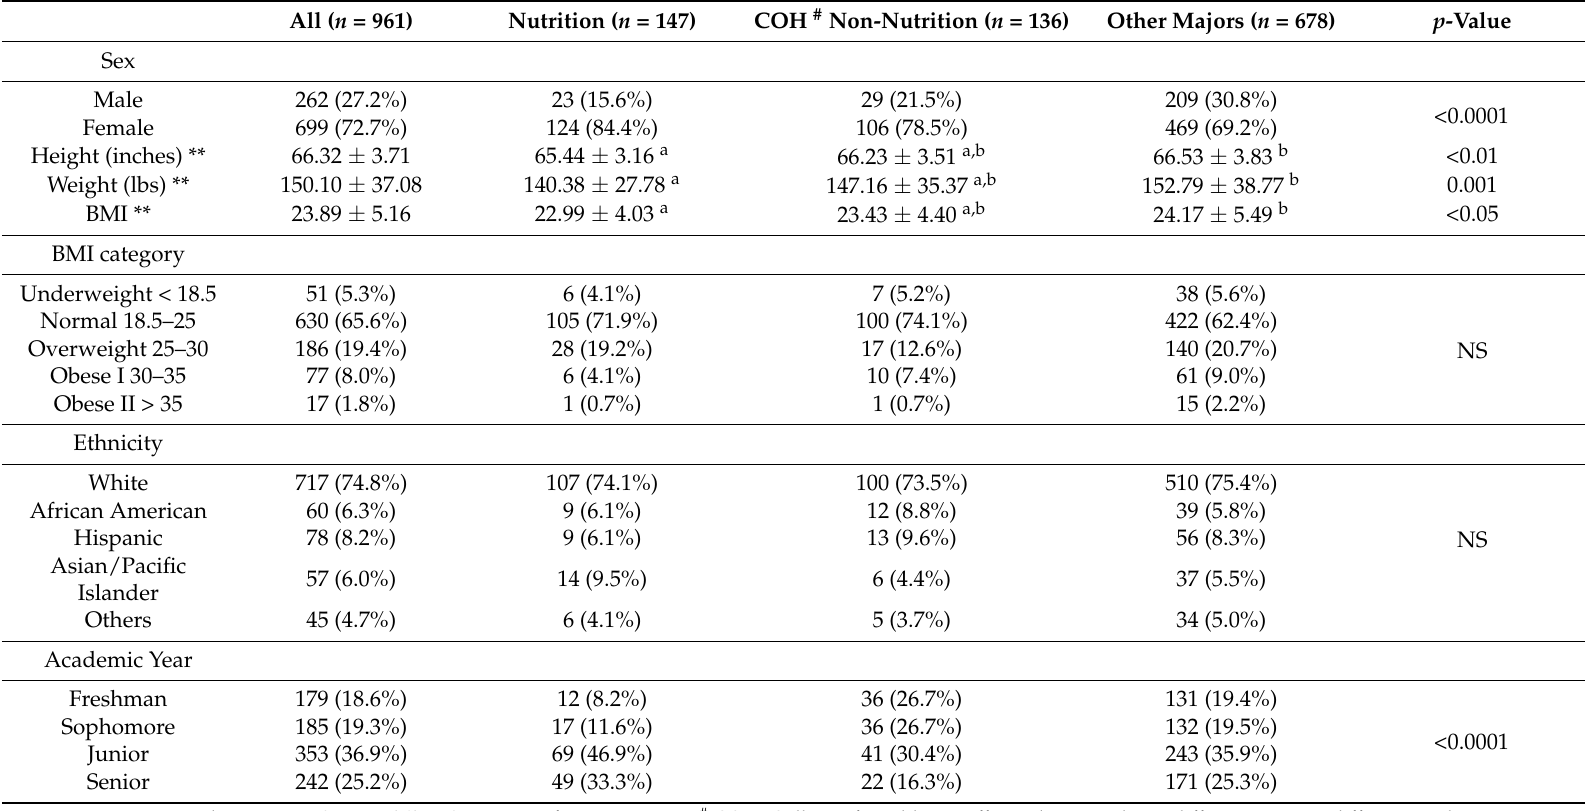
Table 1. Baseline characteristics